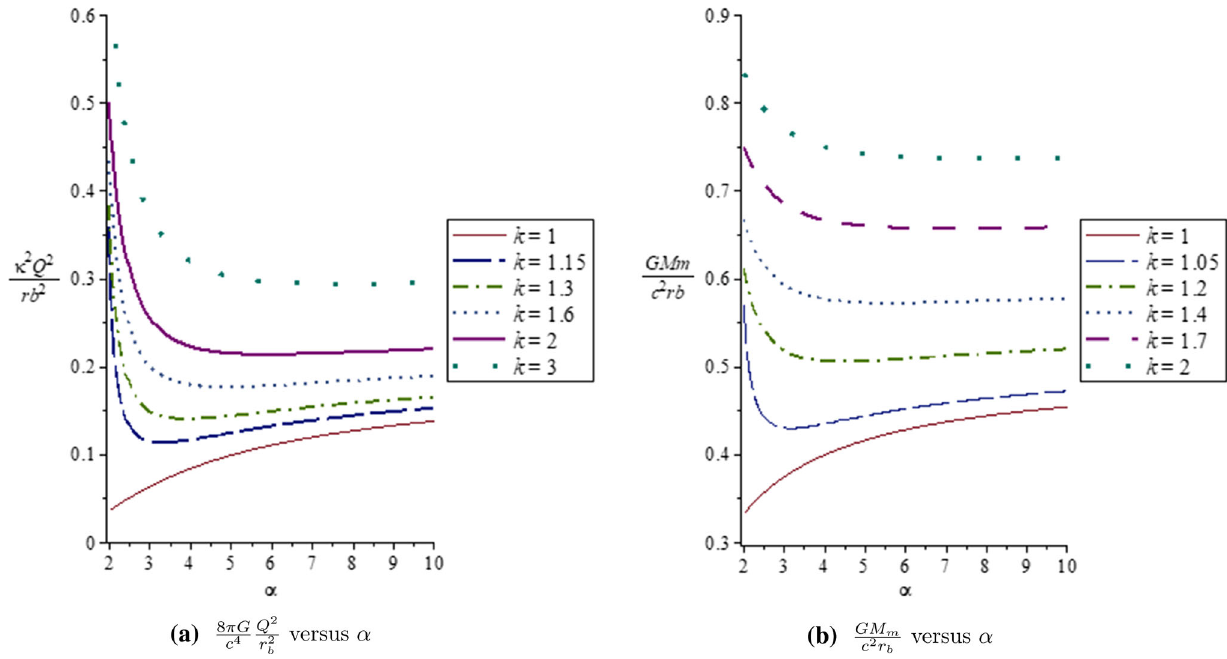
Fig. 2 Variation of the dimensionless quantities which are related with the total electric charge Q and the matter mass M m as a function of the dimensionless parameter α for some different k